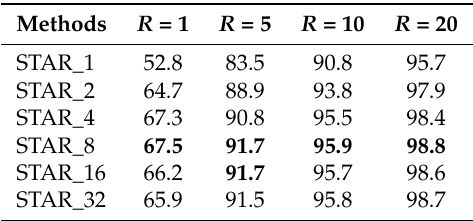
Table 3. Evaluation of the number of segments in a walking cycle on iLIDS-VID. “N” in “STAR_N” is the number of segments. Bold values indicate the best